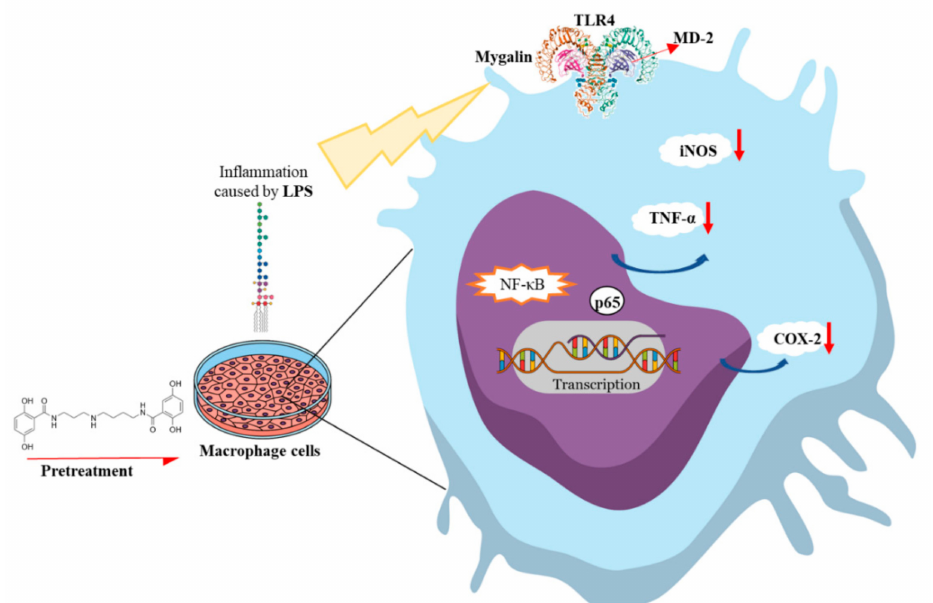
Figure 11. Model of the mechanisms of action of mygalin to inhibit LPS via TLR4. Mygalin binds to the MD-2 protein and blocks the inflammatory e ff ects of LPS.